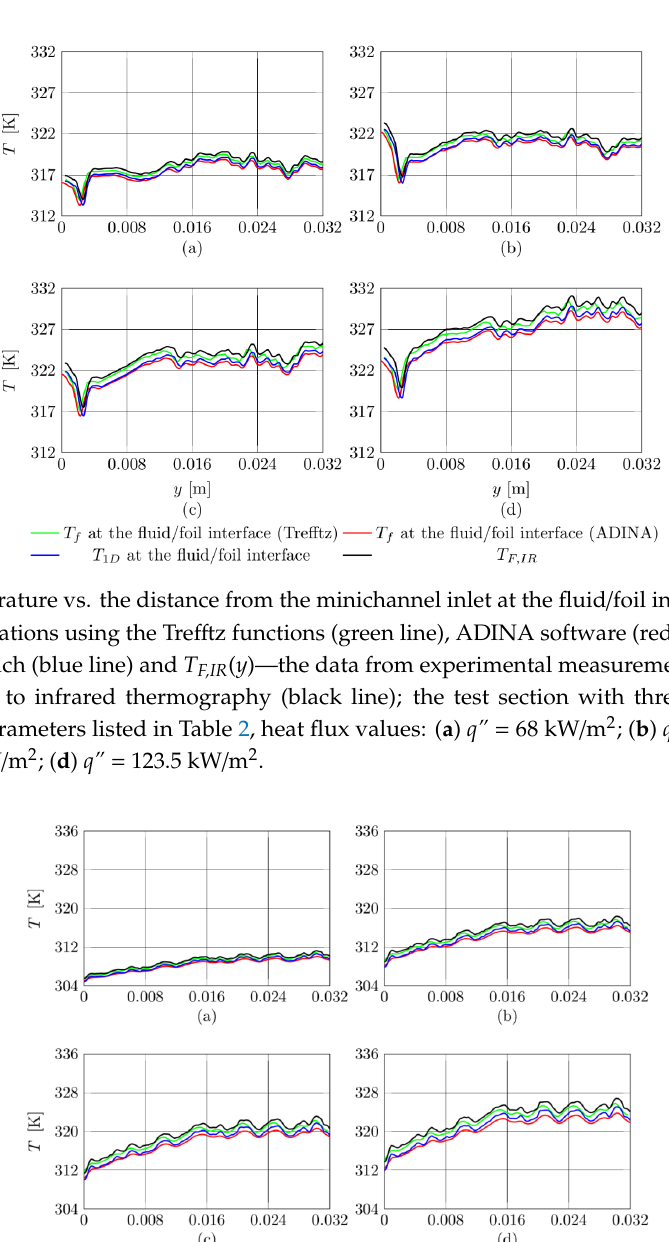
Figure 10. Distribution of temperature in the foil and in the fluid obtained from the FEM computations carried out by ADINA software; the test section with three minichannels; experimental parameters listed in Table 2; heat flux values: ( a ) q’’ = 68 kW/m 2 ; ( b ) q’’ = 123.5 kW/m 2 .